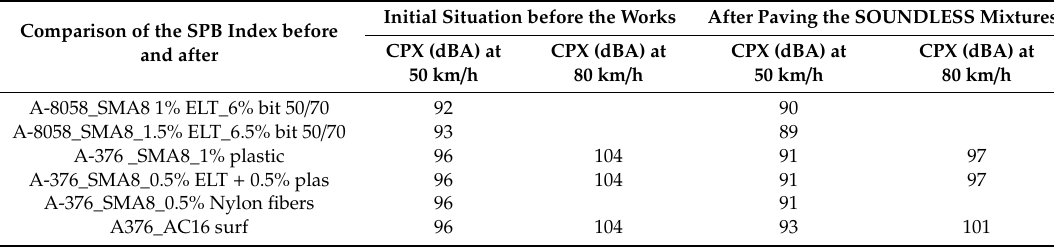
Table 5. CPX_p values before and after paving the mixtures. Table 5. CPX_ p values before and after paving the